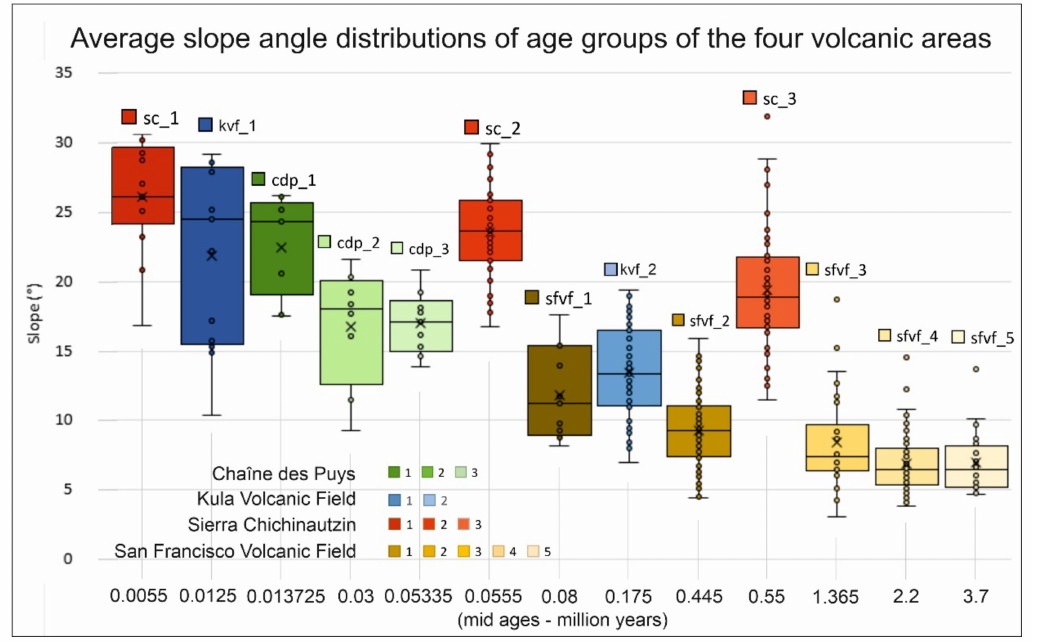
Figure 12. Boxplot diagram of the average slope values of all the four areas and all age groups: Chichinautzin (SC) is marked with reddish shades, Chaîne des Puys (CdP) with greenish, Kula (KVF) with bluish, and San Francisco (SFVF) with brownish-yellowish. Age groups are arranged in ascending order (starting with the oldest age) by the midpoint of the time intervals (see intervals in Figure 2).